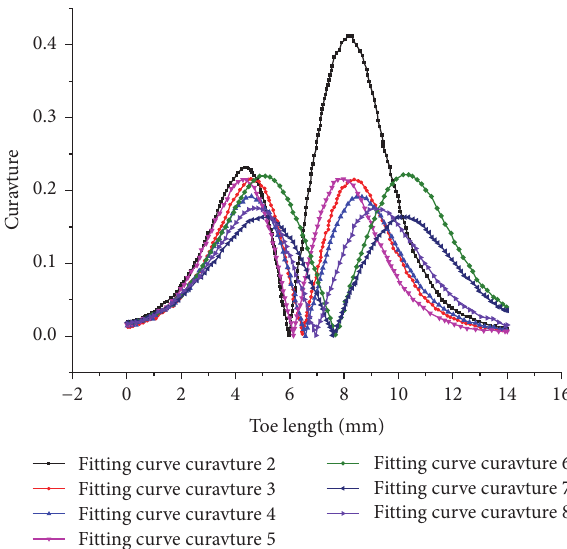
Figure 7: The polynomial fitting curves of the external contours of the Himalayan marmot’s second front claw.